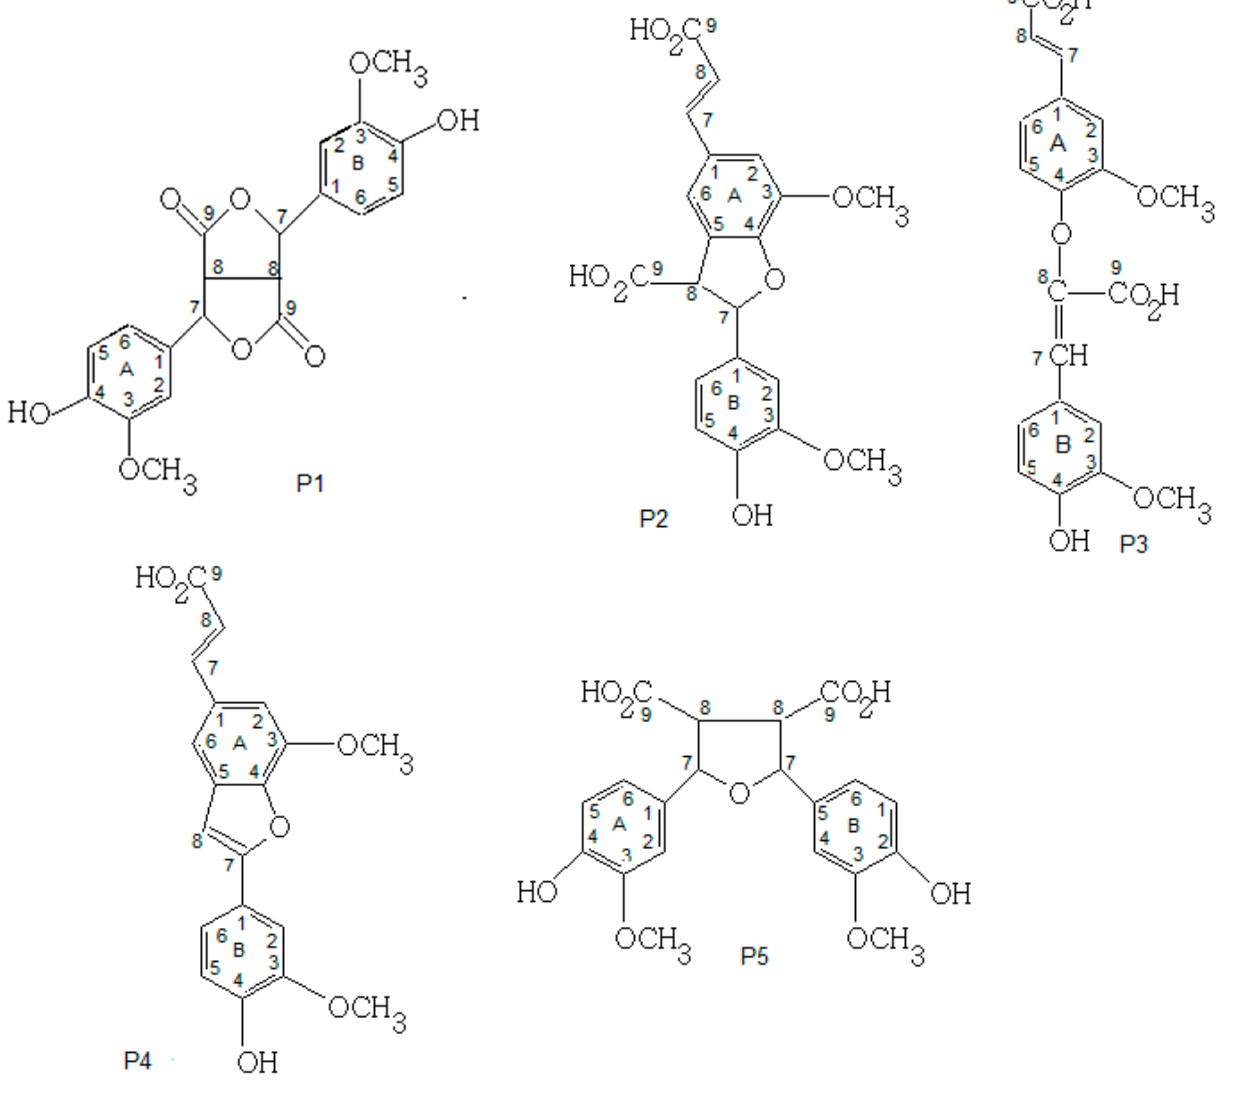
Figure 3. Dehydrodimers (P1, P2, P3, P4, P5) formed during FA oxidation in phosphate buffer at pH 7.5 and 30 °C.